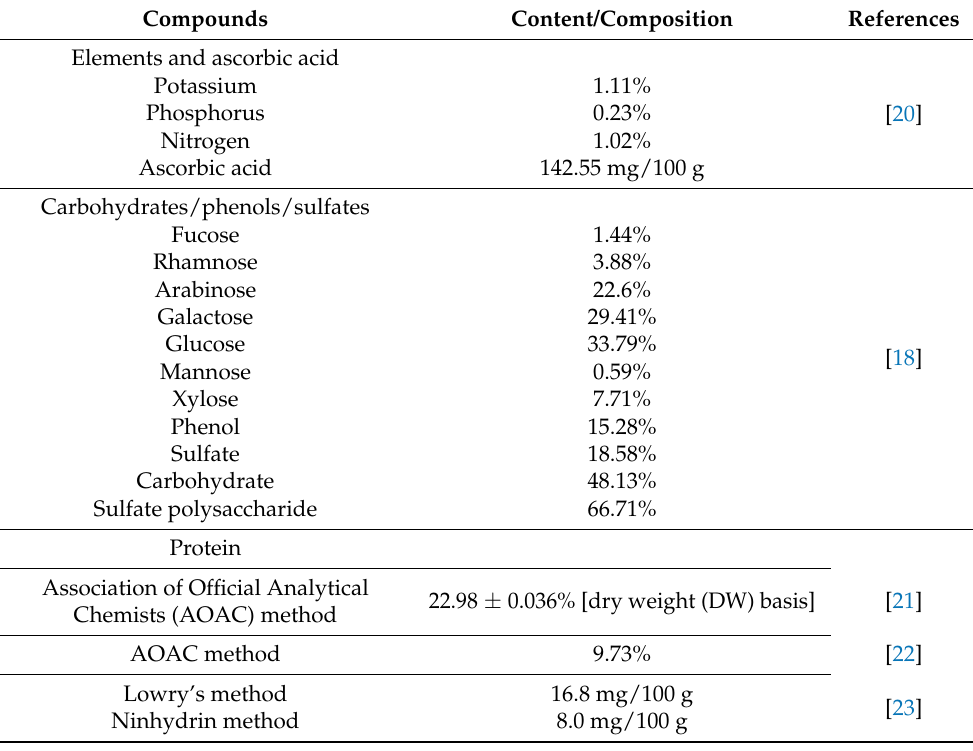
Table 1. Nutritional profile of guava